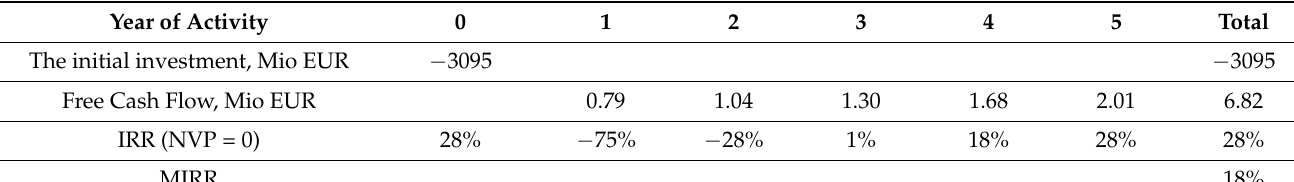
Table 4. Key indexes of the investment project (all data presented in